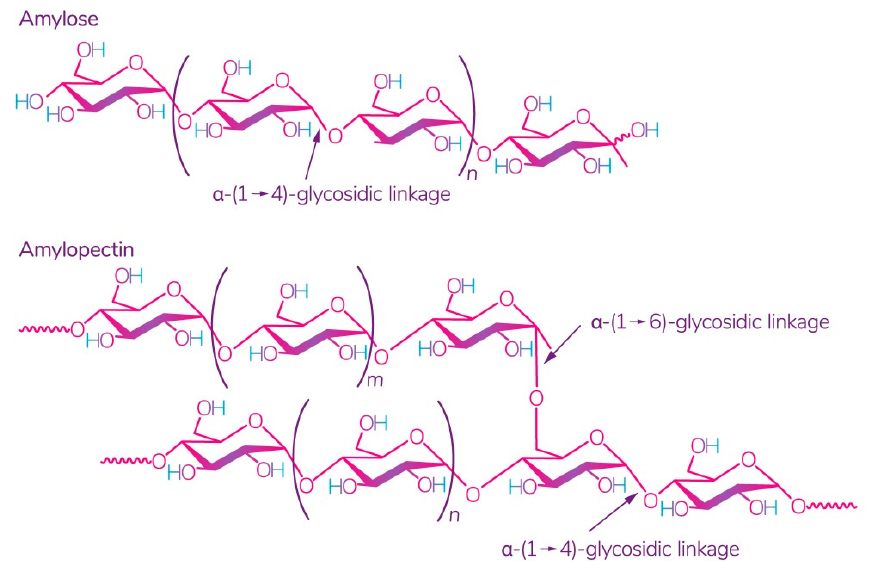
Figure 2. Structure of amylose and amylopectin [30]. Reproduced from Kadokawa, Polymers; published by MDPI, Basel, Switzerland, 2012.